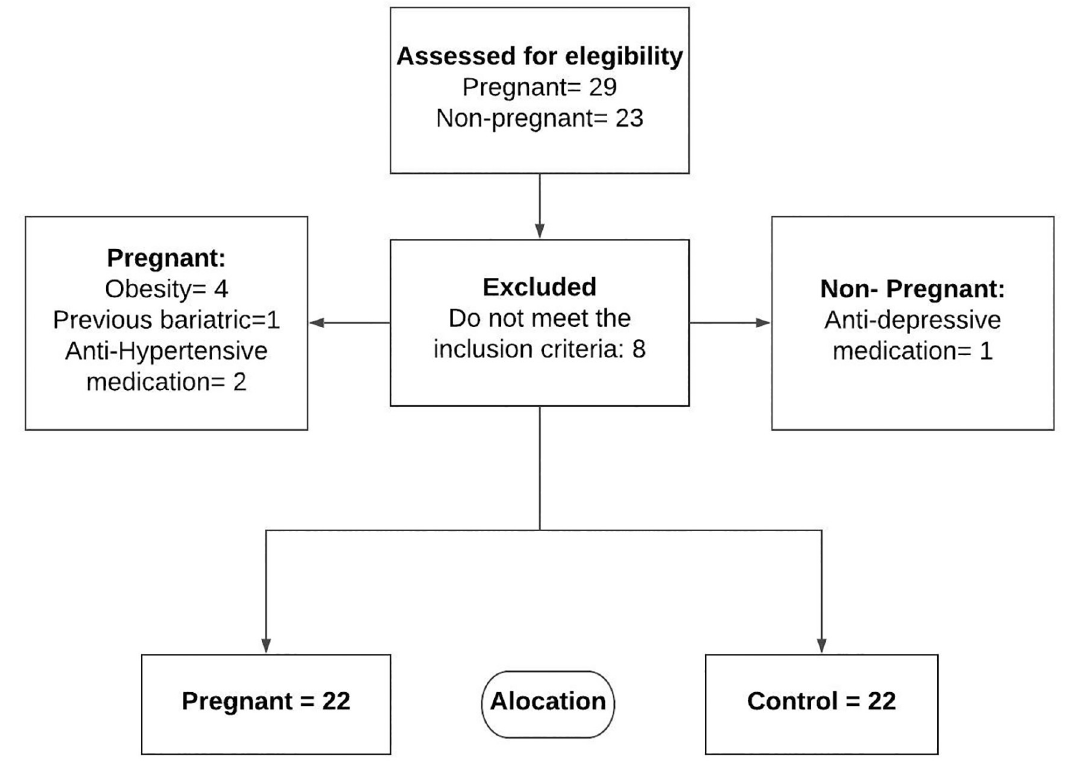
Fig 1. Flowchart of the enrollment. Recruitment and exclusion